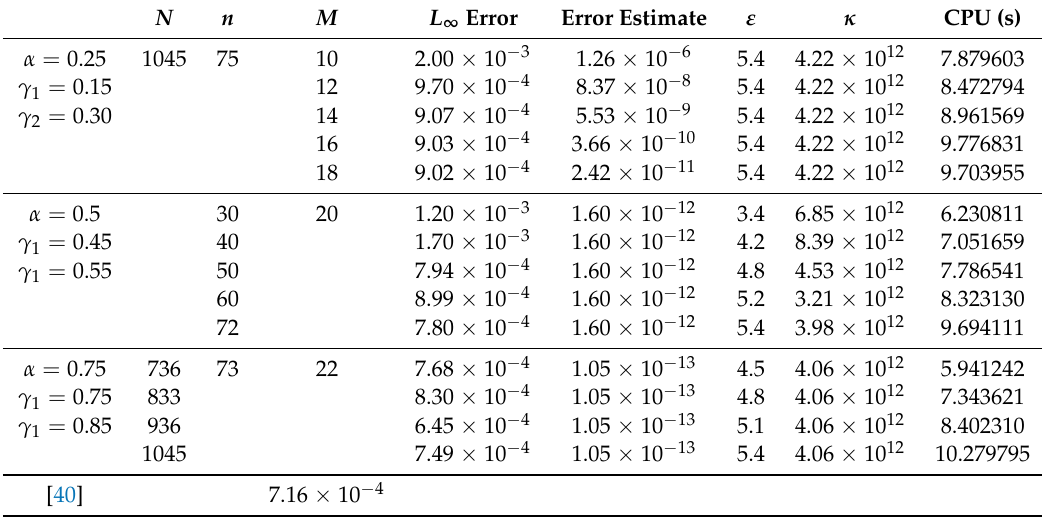
Table 3. Numerical results for the FPIDEs in the L-shaped domain.